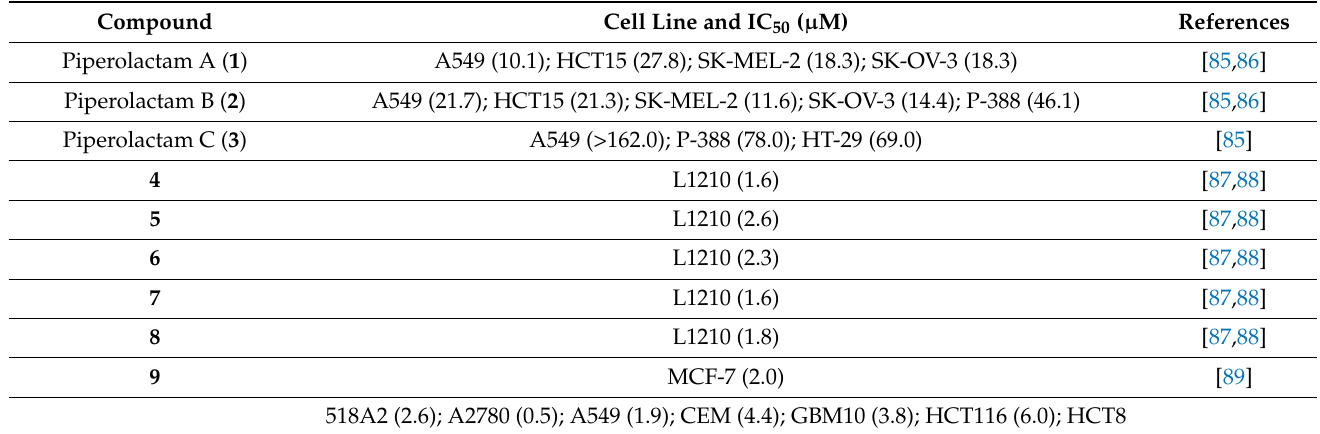
Table 1. Potency (IC 50 ; µ M) of pepper-derived compounds against several cancer cell lines 1